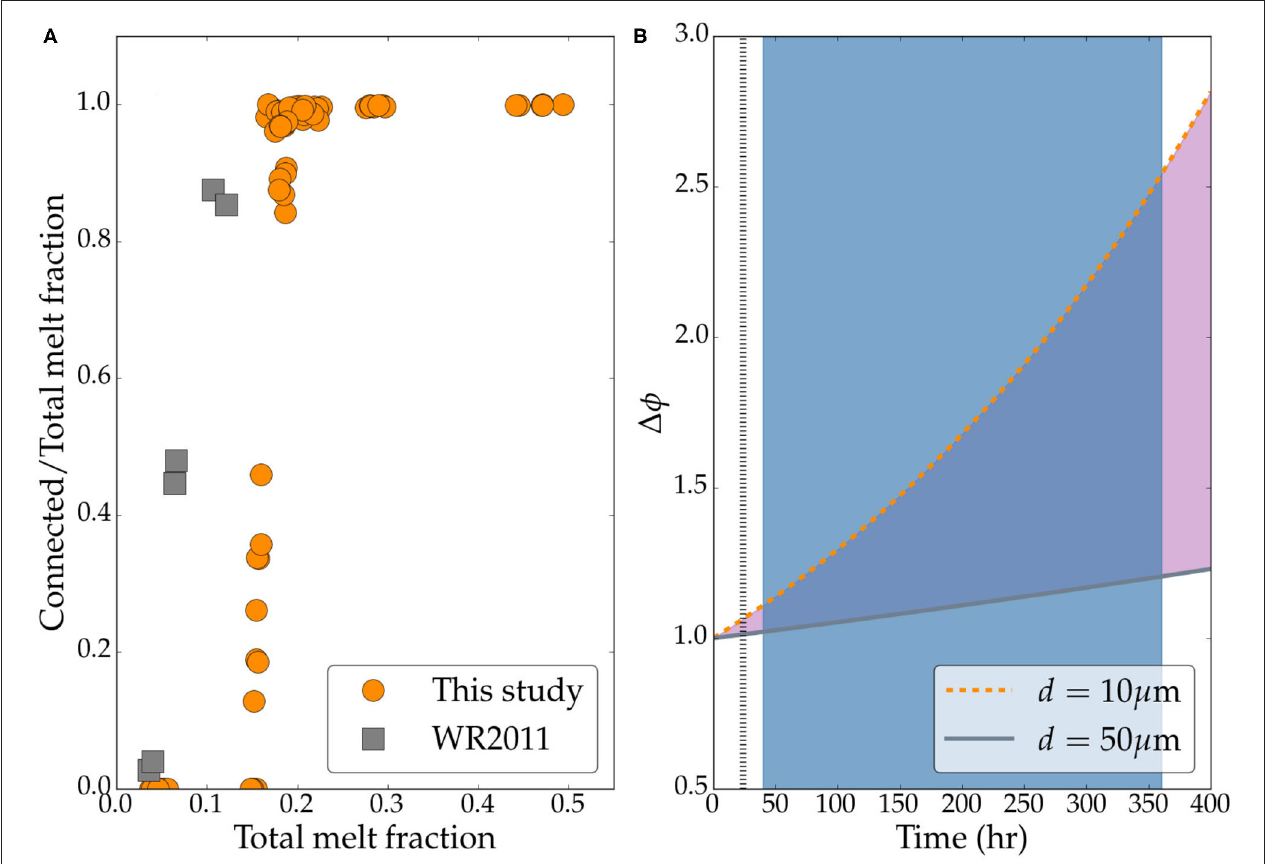
FIGURE 8 | (A) Plot of connected melt fraction as a function of total melt fraction. The gray squares represent data digitally acquired from Figure 7 of Watson and Roberts (2011). Filled orange circles are data from this study. (B) Model prediction of melt enrichment by self segregation. The legends indicate the values of grain size used in calculating each curve. The vertical broken line marks 24 h, the duration of experiments in Watson and Roberts (2011), while the blue shaded area represents the duration of annealing for the samples used in this study. See text for more details on the